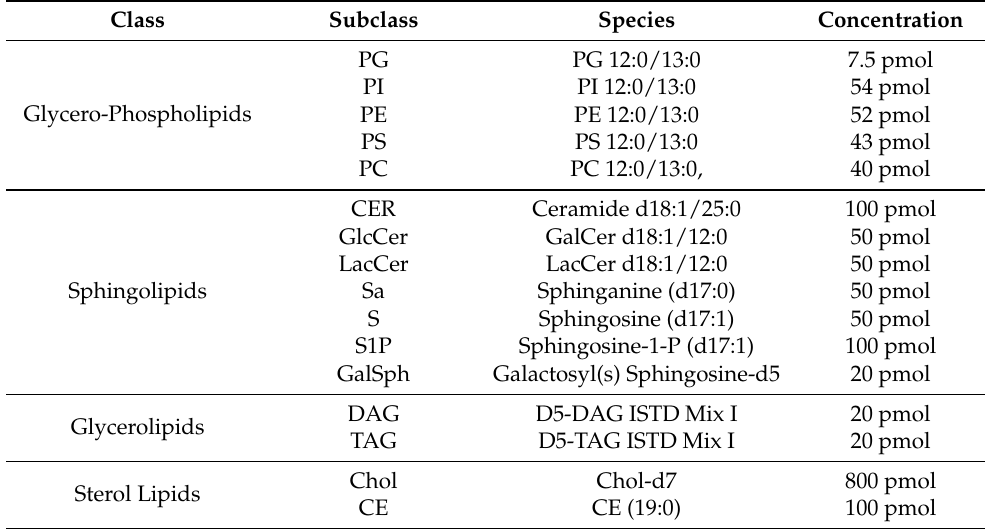
Table 1. List of internal standards used for lipidomics